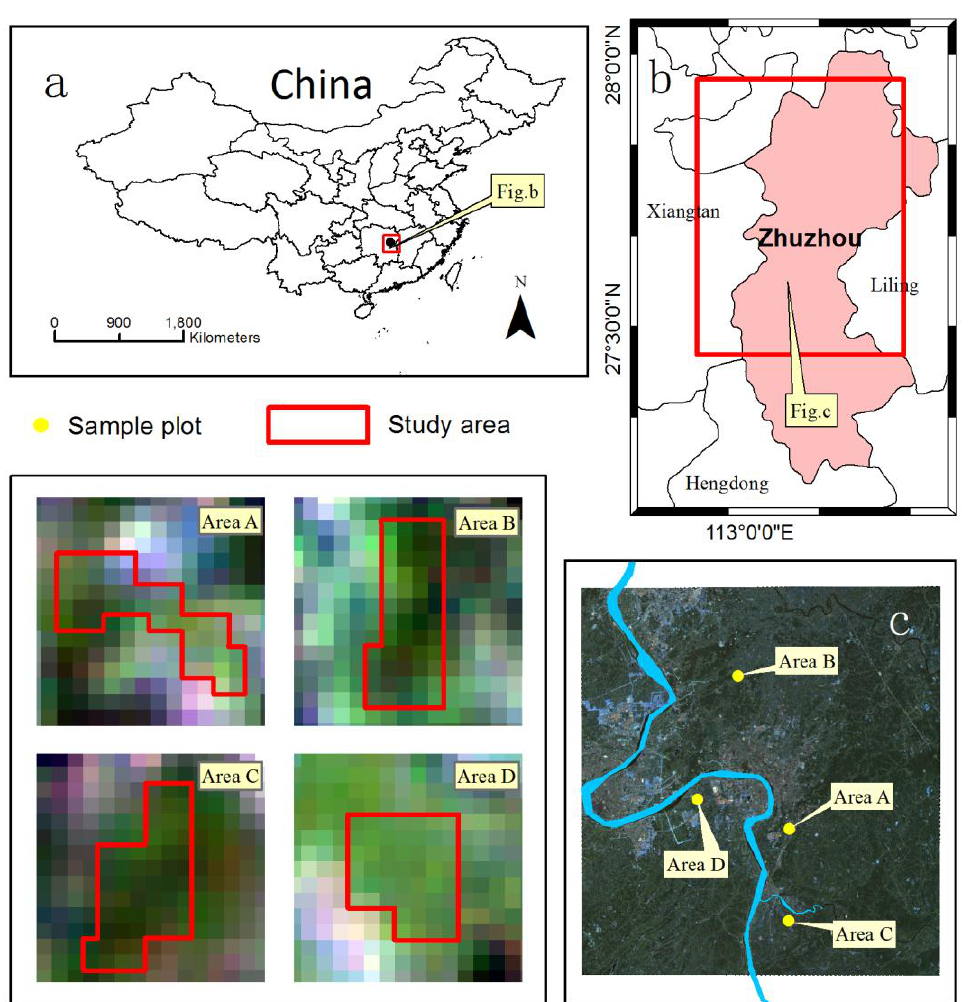
Figure 1. The experiment areas A, B, C, and D in Zhuzhou, Hunan Province in China and the spatial distribution of sample points.